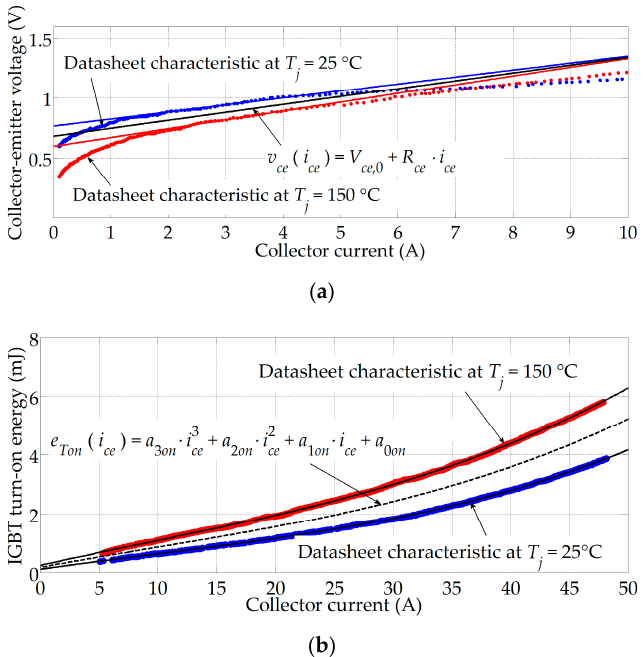
Figure 2. I–V characteristics ( a ) and turn-on characteristics ( b ) of the utilized IGBT.